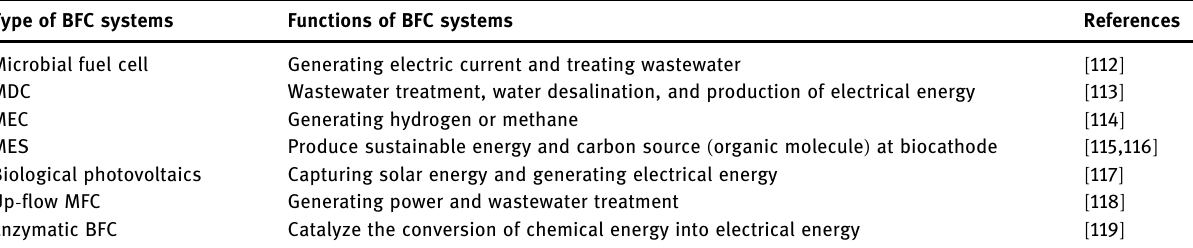
Table 1: Common reported BFC systems and their general functions till 2019 Type of BFC